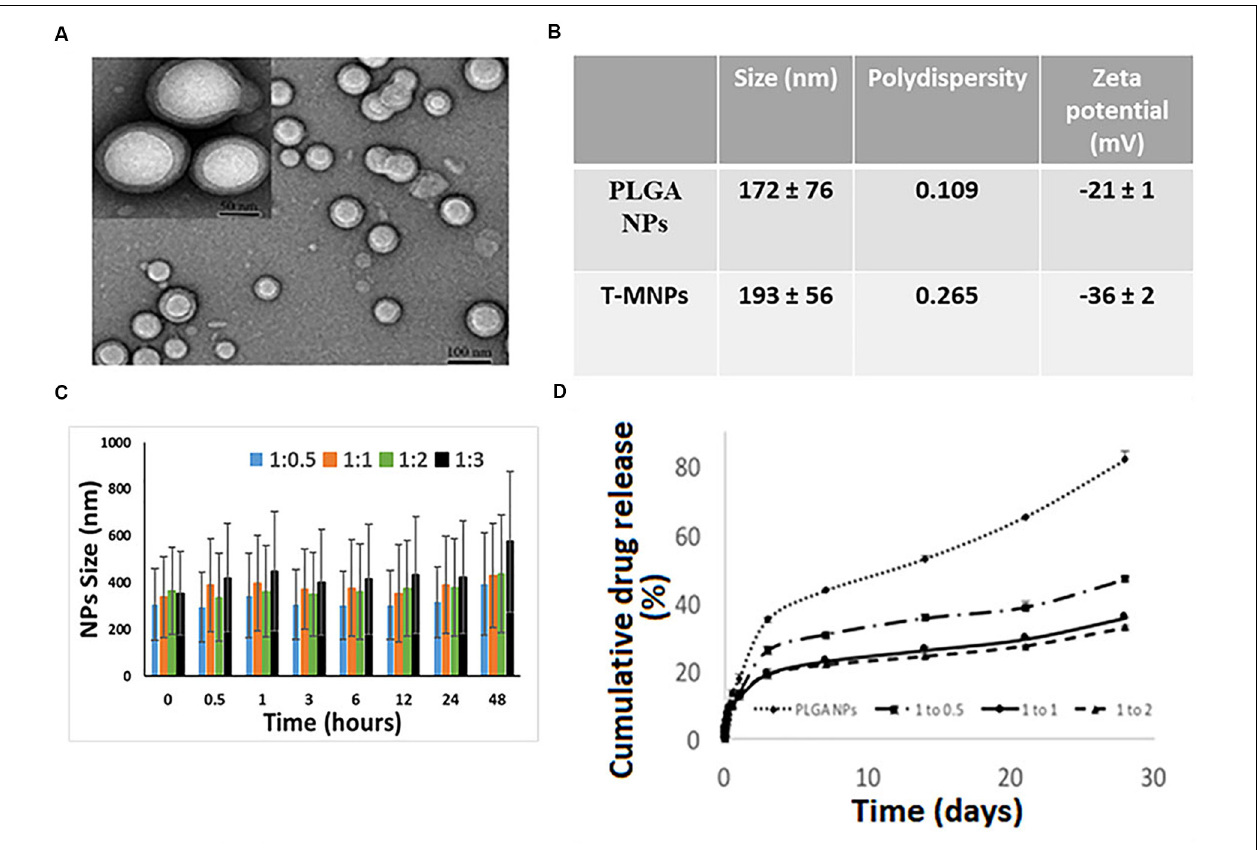
FIGURE 1 | Characterization of T-MNPs. (A) TEM images of T-MNPs at 1:2 NP to membrane protein weight ratio. (B) Size, polydispersity and zeta potential of PLGA NPs and T-MNPs analyzed using Dynamic Light Scattering (DLS). (C) Stability of T-MNPs in 0.9% saline (at varying NP to membrane protein weight ratios: 1:0.5, 1:1, 1:2, and 1:3) evaluated by change in NPs size over a 2-day period using DLS. (D) Cumulative% drug release from T-MNPs (varying NP to membrane protein ratios of 1:0.5, 1:1, 1:2 versus PLGA NPs) performed in phosphate buffered saline over 28 days. Samples were analyzed using UV-vis